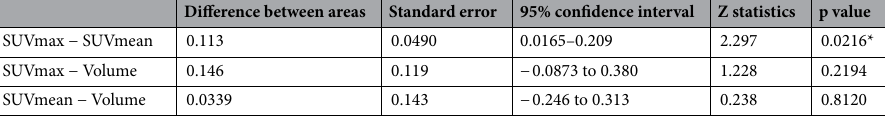
Table 3. Pairwise comparison of ROC curves. *Statistically significant.